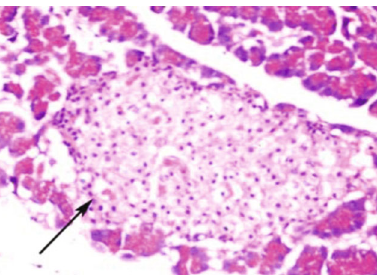
Figure 1: Photomicrograph of pancreatic tissue of control animal showing intact pancreatic islet (arrow) (H&E) ( × 400).